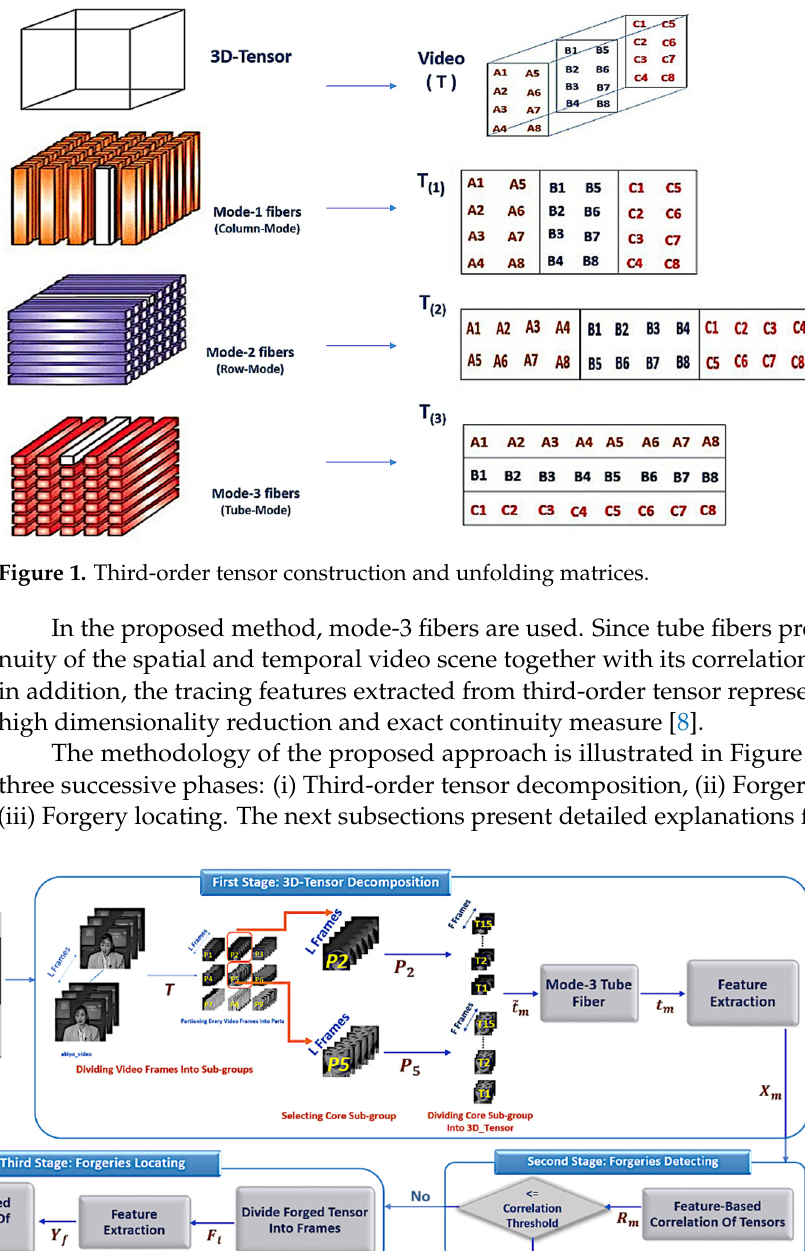
Table 2. List of Symbol abbreviations.